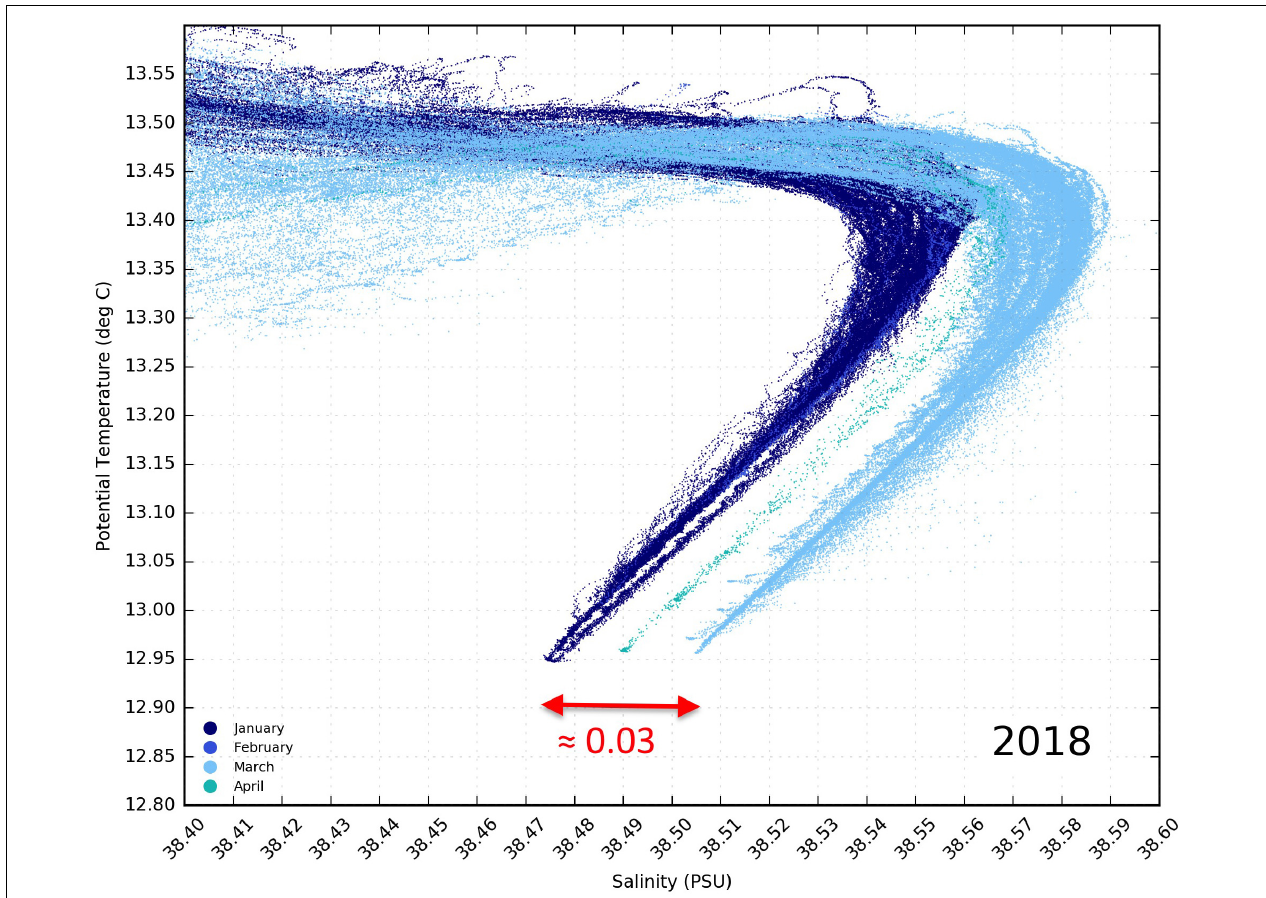
FIGURE 1 | Deeper, more stable water, θ /S plot for four of the SOCIB Ibiza Channel monitoring line glider missions during 2018.